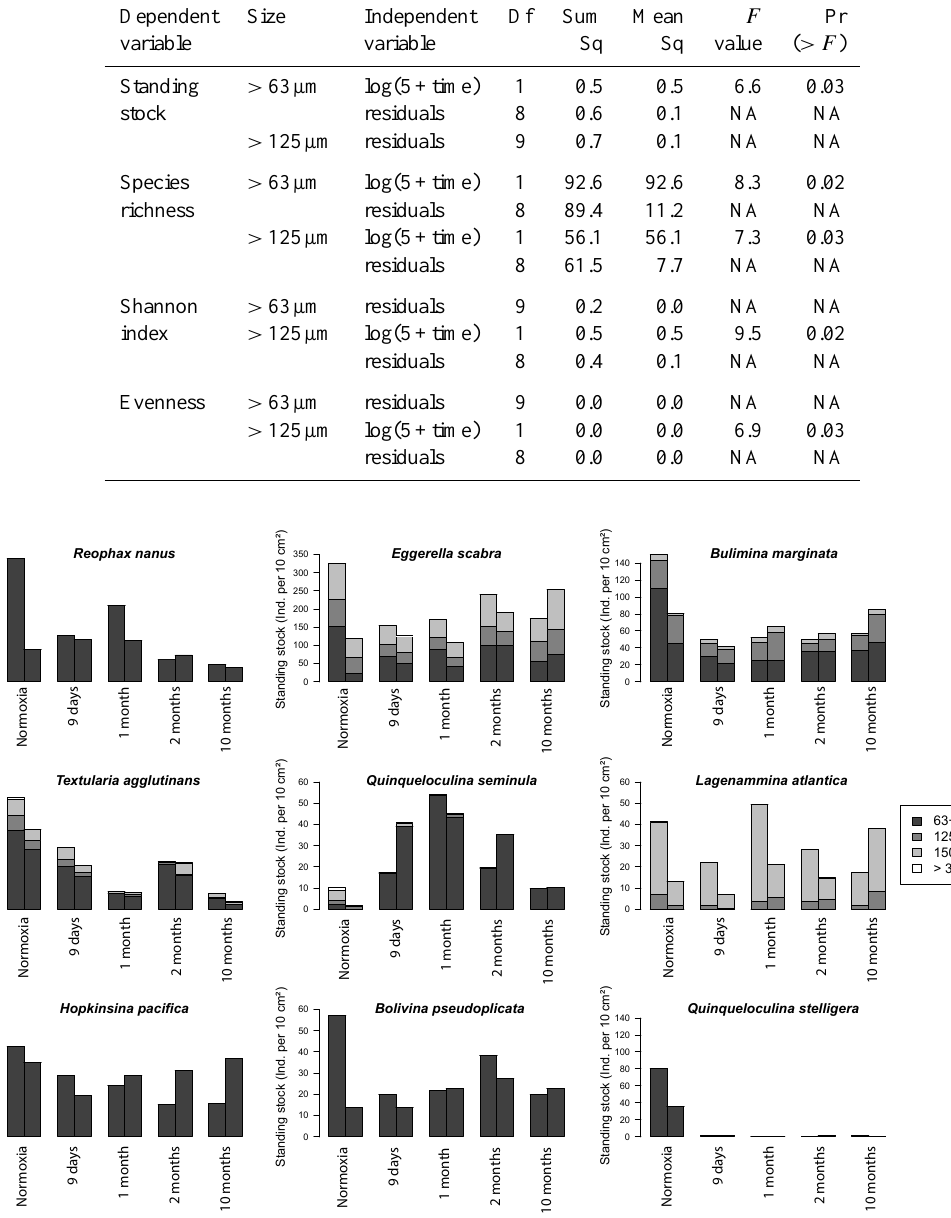
Fig. 2. Standing stock of the nine major species in all the sampled cores (two replicate cores each time) in all studied size fractions in the whole core (0–5cm). Note the different vertical scales for the various